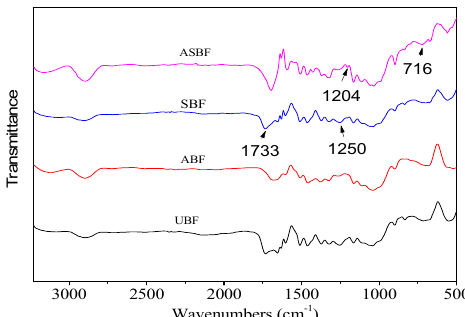
Figure 2. Fourier transform infrared spectroscopy (FTIR) spectra of BF modified by various methods.